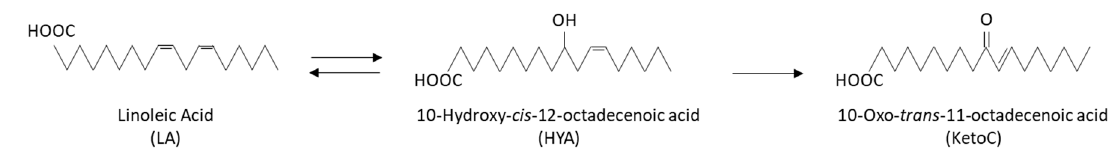
Figure 1. Chemical structure of these metabolites [26]. Lactobacillus plantarum converts LA to various metabolites (HYA and KetoC) through saturation process. HYA has a hydroxy-group, while KetoC has an oxo-group.